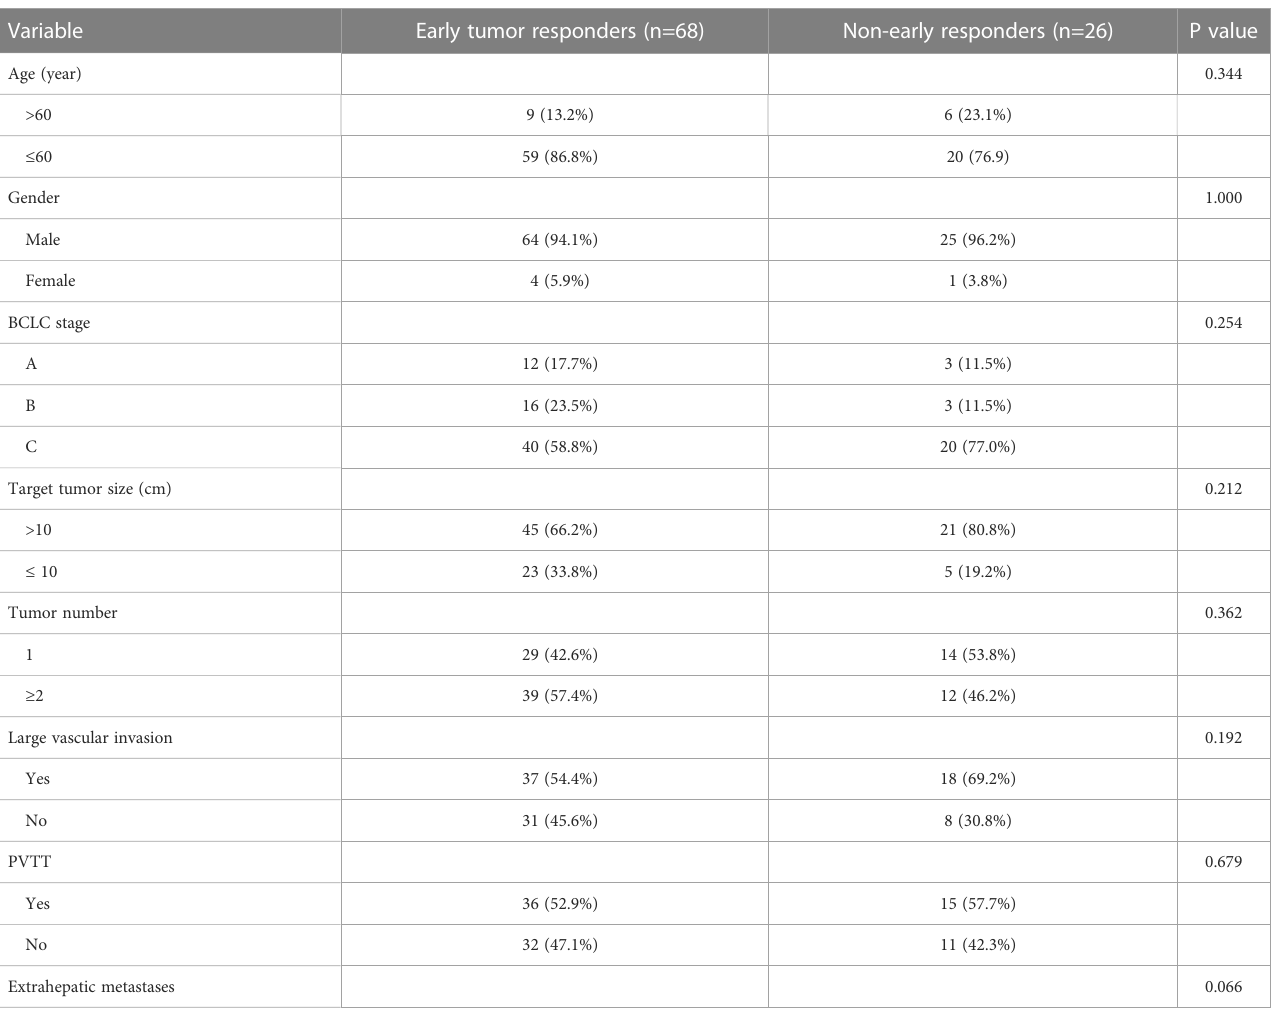
TABLE 1 Baseline characteristics of 94 patients with initially unresectable